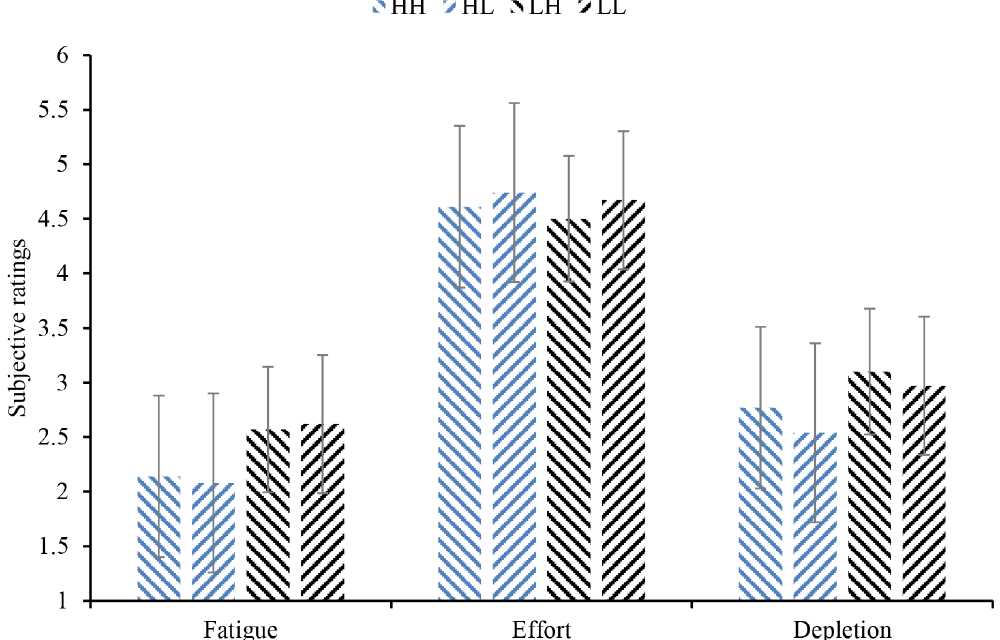
Fig 3. Results of subjective ratings. “HH” represents participants with high trait self-control who finished the high-depletion task; “HL” represents participants with high trait self-control who finished the low-depletion task; “LH” represents participants with low trait self-control who finished the high-depletion task, and “LL” represents participants with low trait self-control who finished the low-depletion task; the same abbreviations are used below and each bar represents the standard error